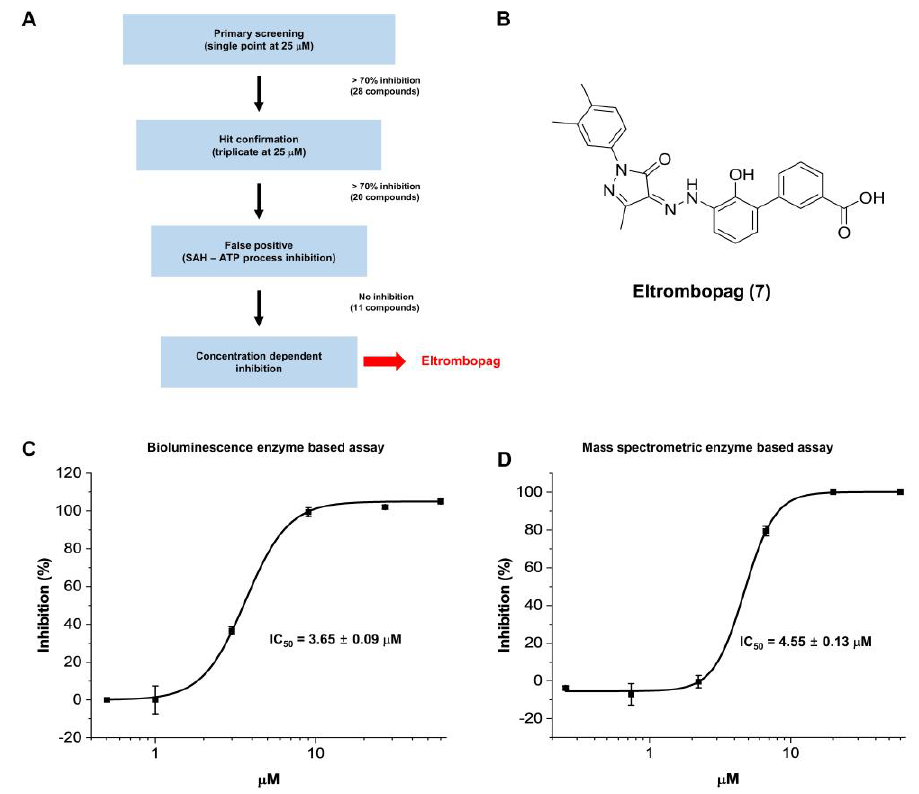
Figure 2. Identification of Eltrombopag as a novel inhibitor of the METTL3-14 complex through library screening. ( A ) Eltrombopag was discovered as a METTL3-14 inhibitor through the described procedure for screening of drug compound library. ( B ) Chemical structure of eltrombopag. ( C ) Concentration-dependent enzymatic inhibitory activity of eltrombopag on METTL3-14 was confirmed in a bioluminescence enzyme-based assay system with an IC 50 value of 3.65 μ M. ( D ) Enzymatic inhibitory activity of eltrombopag on METTL3-14 was confirmed in the mass spectrometric enzyme based assay system with an IC 50 value of 4.55 μ M. Table 1. Methyltransferase selectivity profile of eltrombopag at 10 µ M.